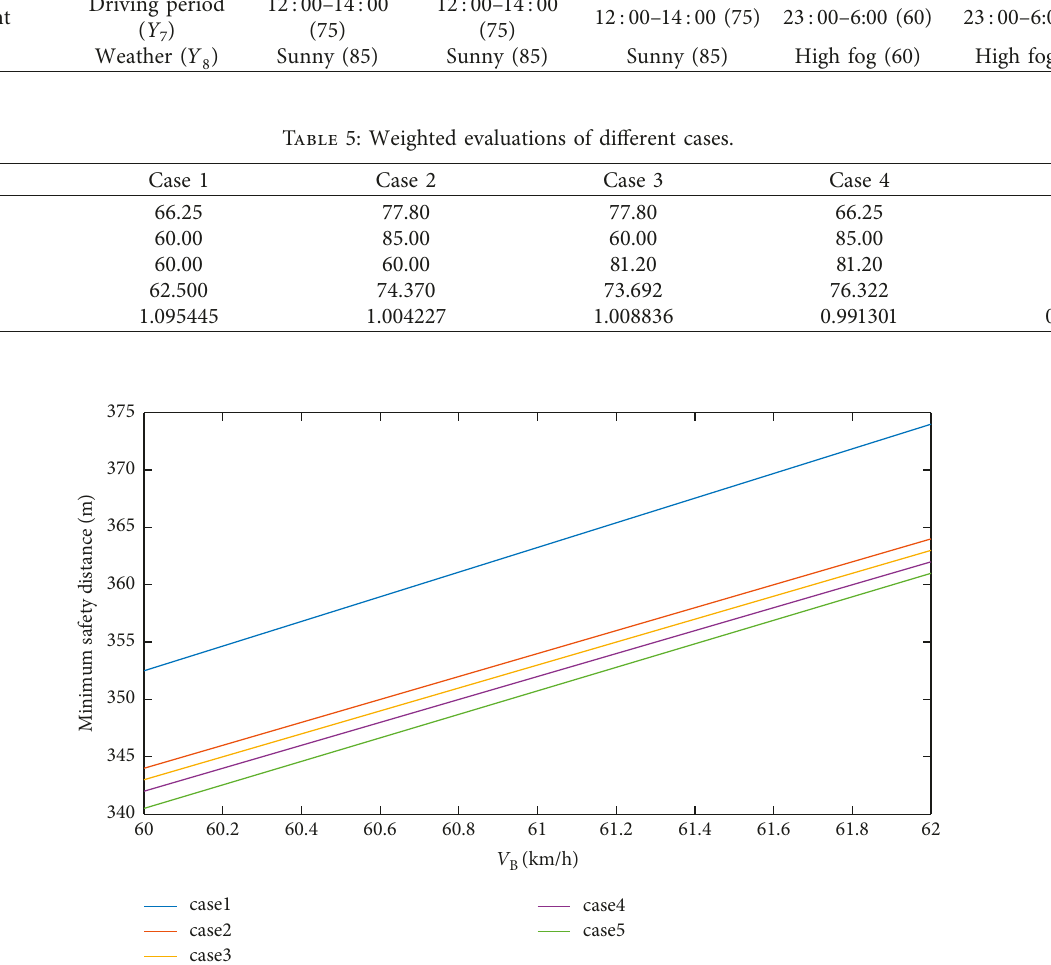
Figure 3: Minimum safety distance under the stationary state of the front